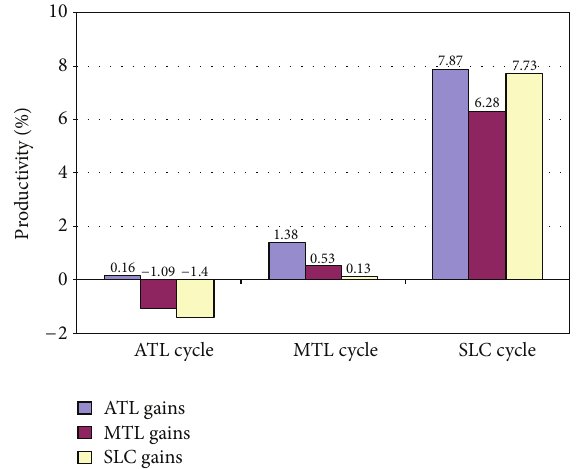
Figure 18: Effect of different gain groups on cycles’ productivity.